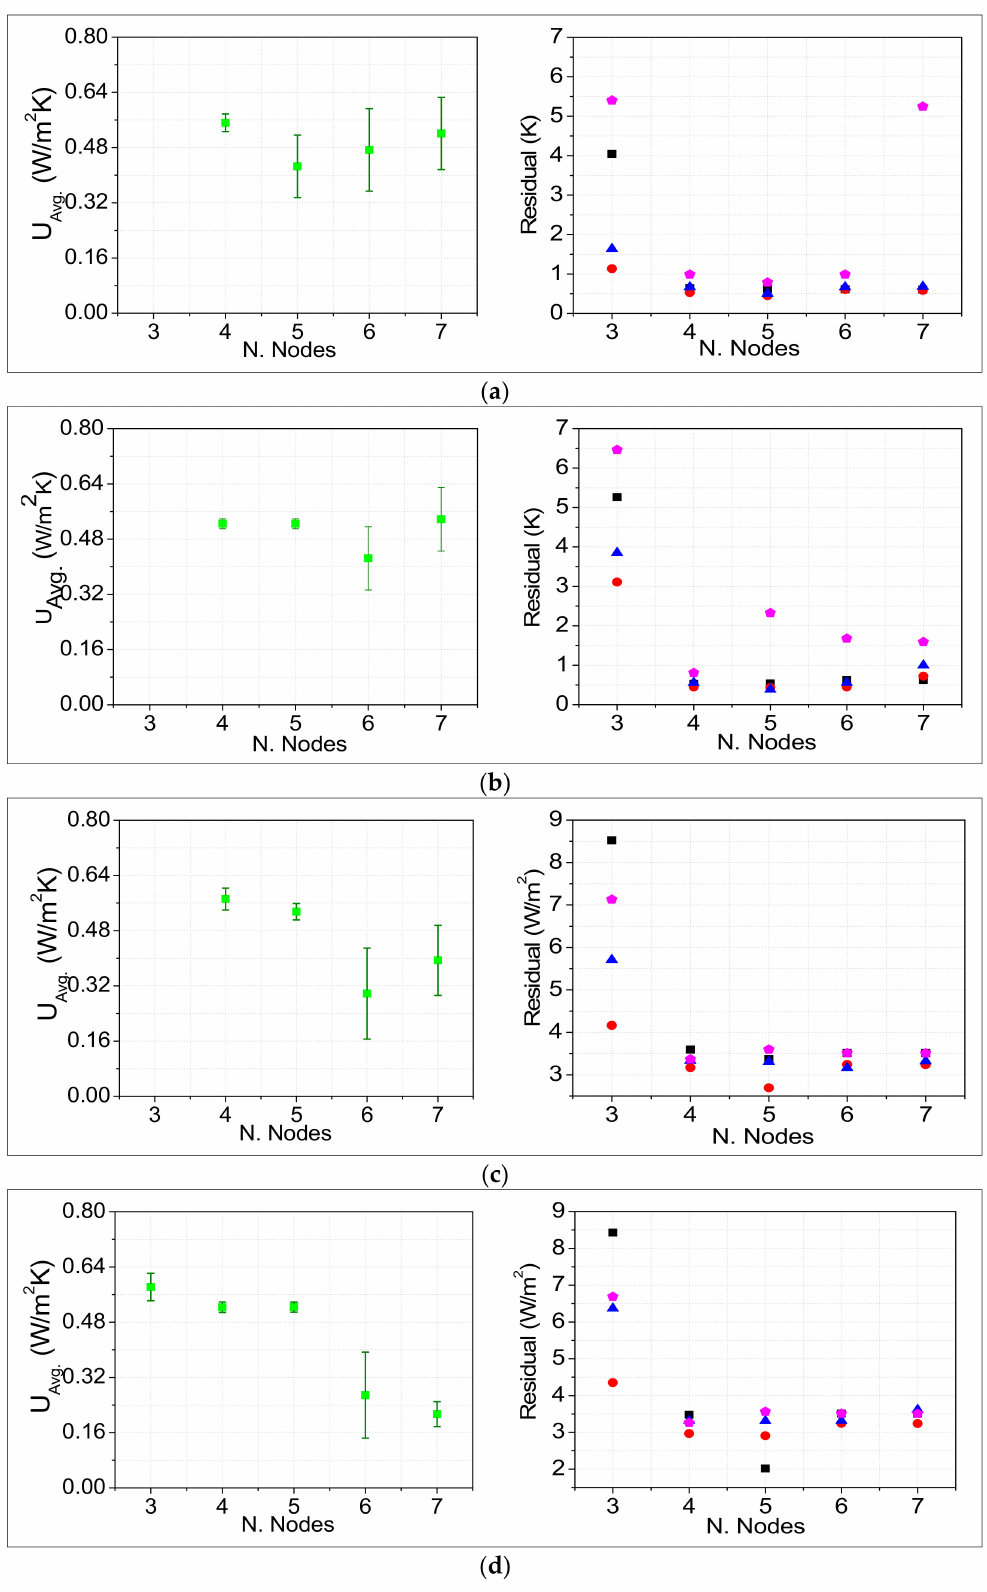
Figure 4. Ceiling. Results obtained using di ff erent candidate models. Left: average of U value for series a, b and c. Right: residuals for series a in black, series b in red, series c in blue and pink for the full data series d. ( a ) Including solar radiation. Output: T i , ( b ) not including solar radiation. Output: T i , ( c ) including solar radiation. Output: ϕ ceiling , ( d ) not including solar radiation. Output: ϕ ceiling